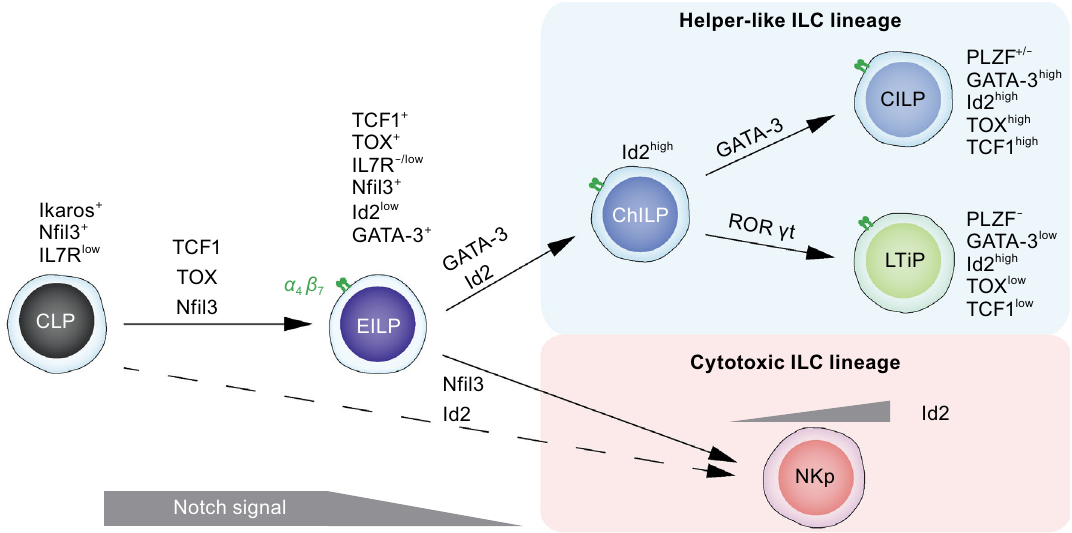
Figure 1. Critical transcription factors regulate ILC development. After the stage of common lymphoid progenitor (CLP), transcription factors such as TCF1, TOX and N fi l3, together with the Notch signals, promote the generation of an early innate lymphoid progenitor (EILP) expressing Integrin α 4 β 7 . EILP has the potential to become both the helper-like innate lymphoid cell